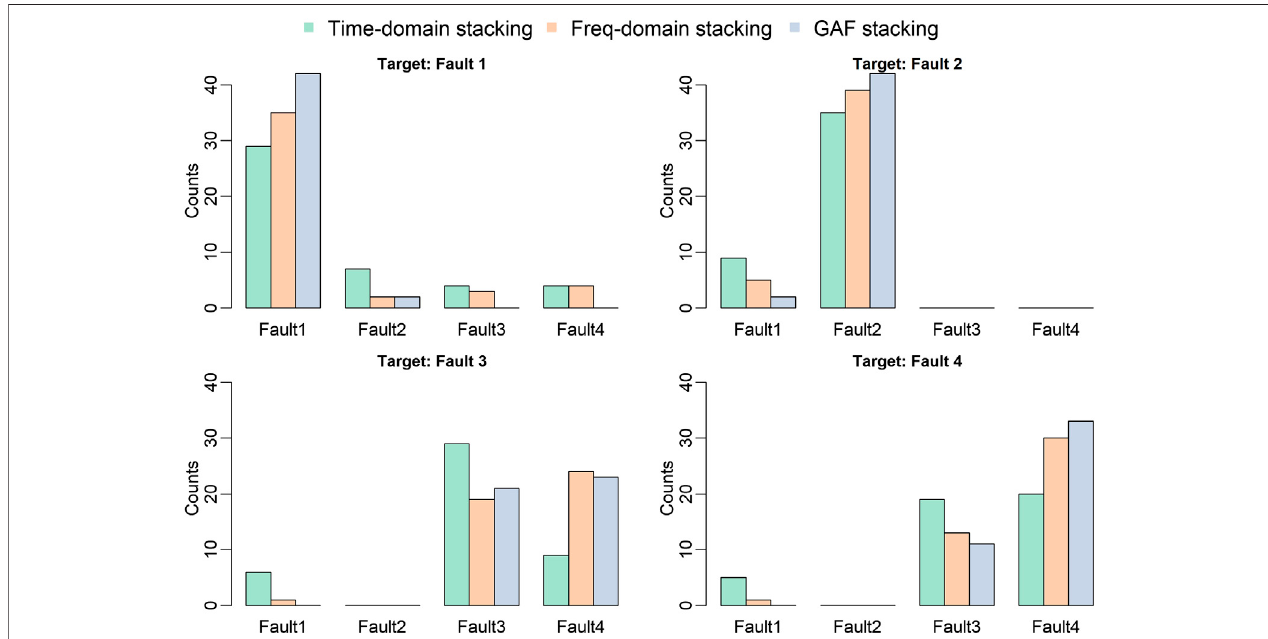
FIGURE 9 | Evaluation of CNN model predictions resulting from different encoding